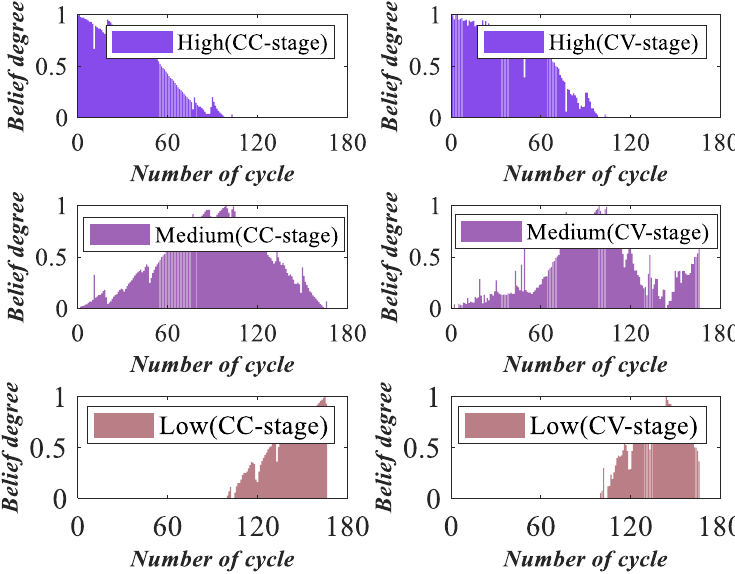
Figure 6. Belief distributions of observation indicators.